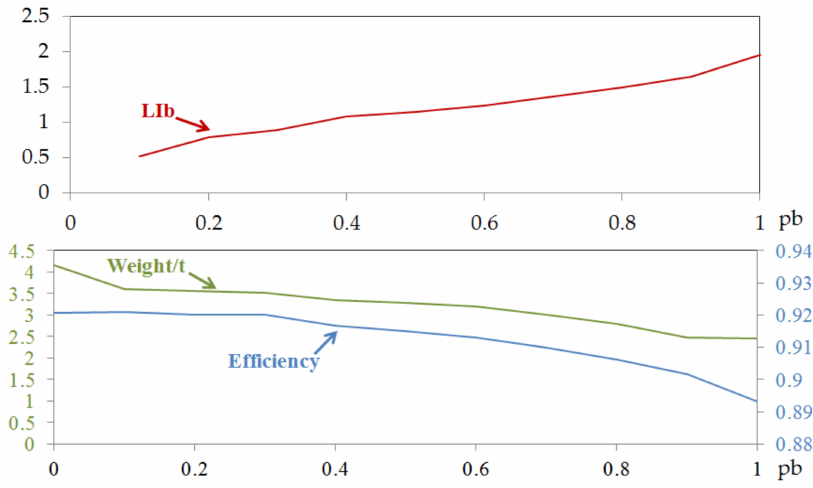
Figure 11. Weight, battery loss index, and the system efficiency curves under the optimal sizing results of each power